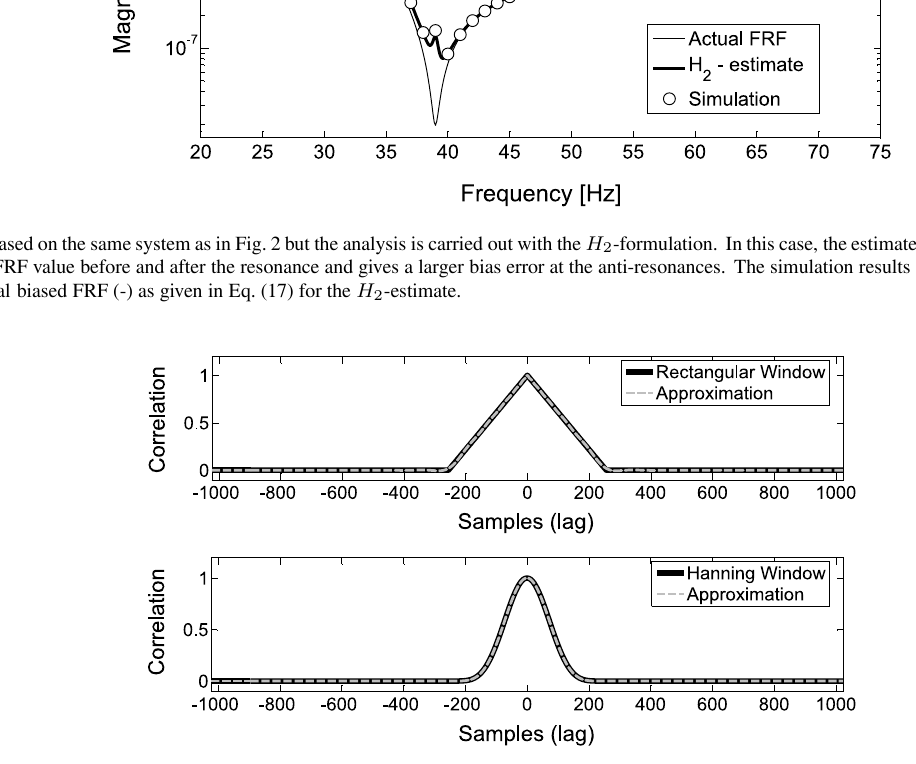
Fig. 4. The discrete deterministic autocorrelation function of a rectangular window (above) and a Hanning window (below) is shown together with a curve fi t consisting of a sum of real exponentials as given in Eq. (22). 100 coef fi cients are used in this example. The accuracy of the proposed bias expressions for the rectangularwindow andthe Hanningwindow is demonstrated next. The time-response from a second-order system, with relative damping ζ = 0.005 and natural frequency f 0 = 50 Hz, is simulated using a sampling frequency of Fs = 2000